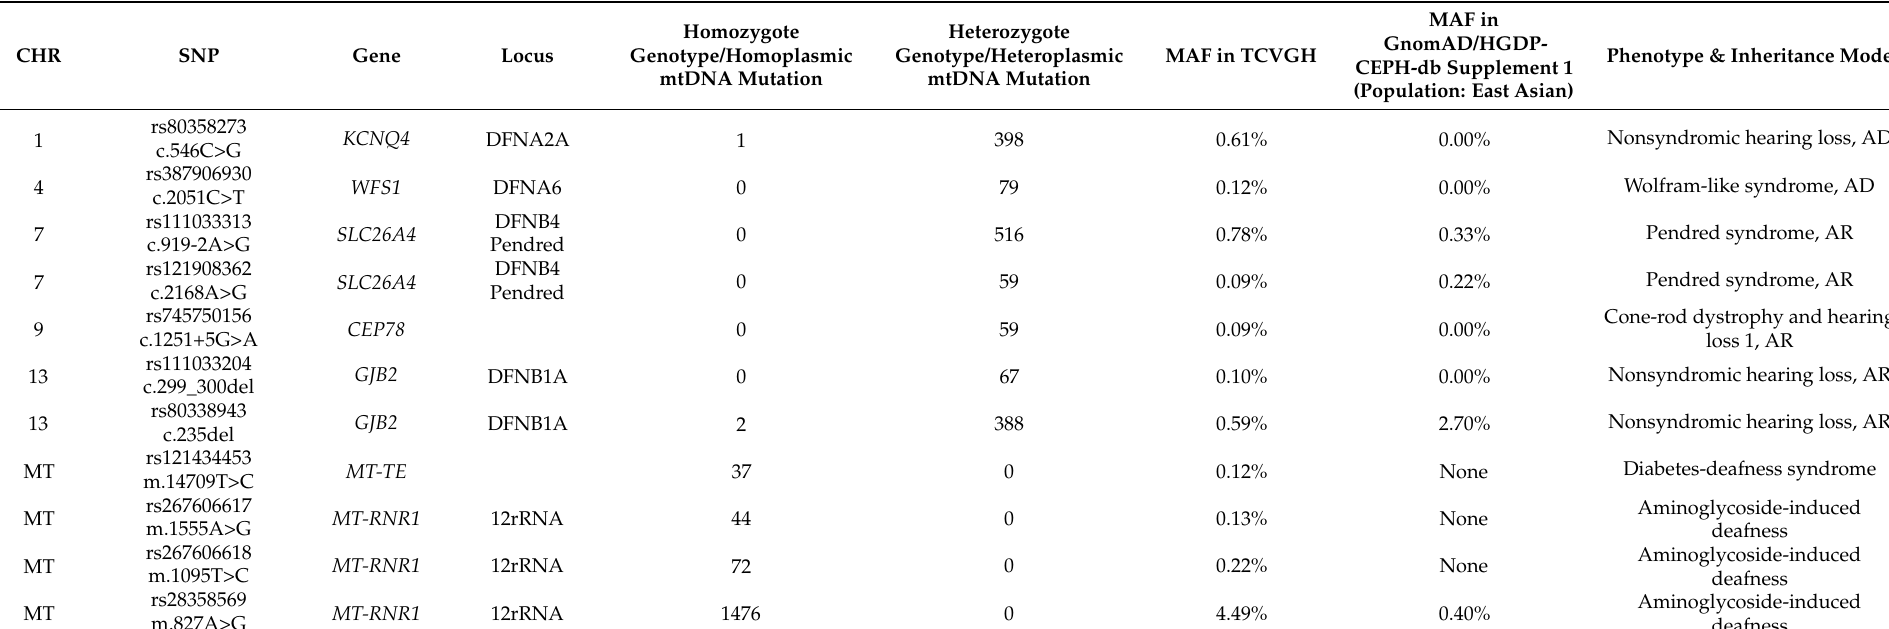
Table 1. Genetic variants associated with hearing loss among the 32,728 participants from the